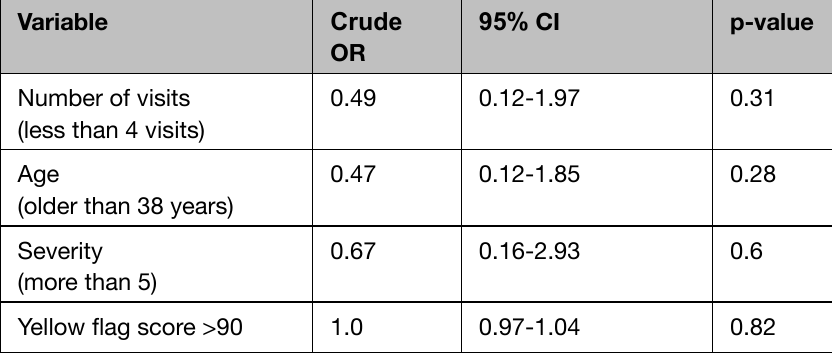
Table 6: crude odds for predicting good disability outcome